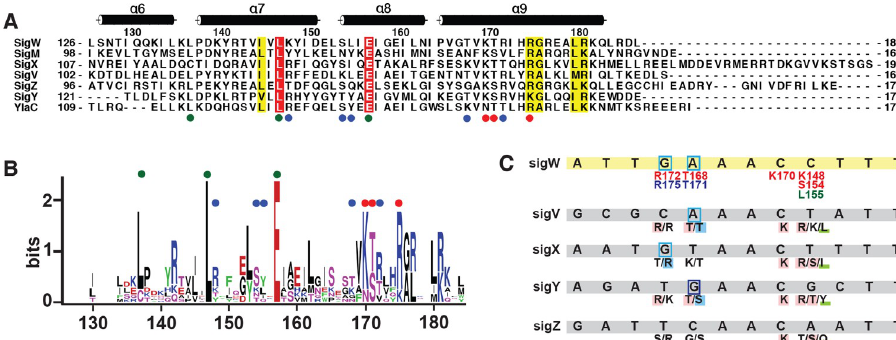
Fig 5. Conserved residues in σ W 4 . (A) Sequence alignment of σ 4 domains of B . subtilis ECF sigma factors. The highly conserved K137, L148, and E157 are indicated by green circles. Residues that form purine- and backbone-specific hydrogen bonds are indicated by red and blue circles, respectively. (B) Sequence logo for the σ 4 domains of B . subtilis ECF sigma factors. (C) The sequences of the -35 promoter elements for B . subtilis ECF sigma factors. Residues that form hydrogen bonds with the -35 promoter element are predicted based on the interactions between σ W 4 and -35 W and the sequence alignment in (A).